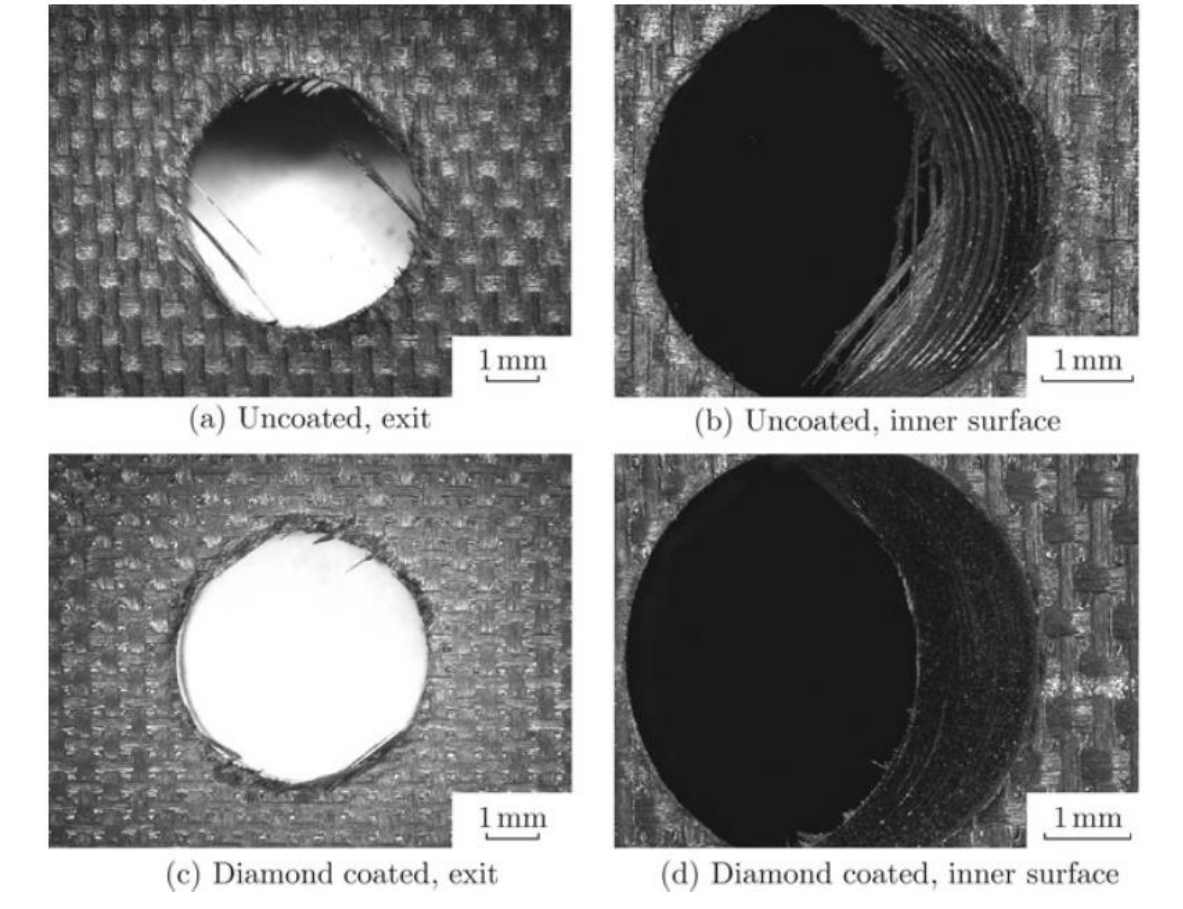
Figure 11. Images for the tenth hole machined by uncoated and diamond-coated drills: ( a ) The outcome made by an uncoated drill, ( b ) the inner surface of the hole made with a drill without coating, ( c ) the outcome made by a diamond-coated drill, and ( d ) the inner surface of the hole made with a drill with diamond coating